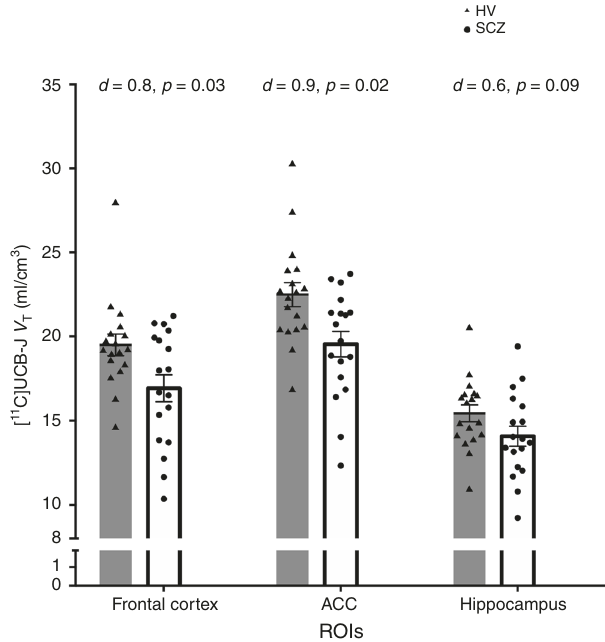
Fig. 1 Regional mean [ 11 C]UCB-J distribution volume ( V T ) by group. Grey bars depict regional mean V T in the healthy volunteer (HV) group, and triangles represent individual HV V T ( n = 18). Hollow bars depict mean V T in the schizophrenia (SCZ) group, and circles indicate individual SCZ patient V T ( n = 18). p Values reported here are FDR-adjusted p values. [ 11 C] UCB-J V T was signi fi cantly reduced with large effect sizes (Cohen ’ s d > 0.8) in the SCZ compared to the HV group in the frontal cortex and anterior cingulate cortex (ACC). [ 11 C]UCB-J V T was not signi fi cantly altered in the hippocampus. Error bars indicate standard error of the mean.